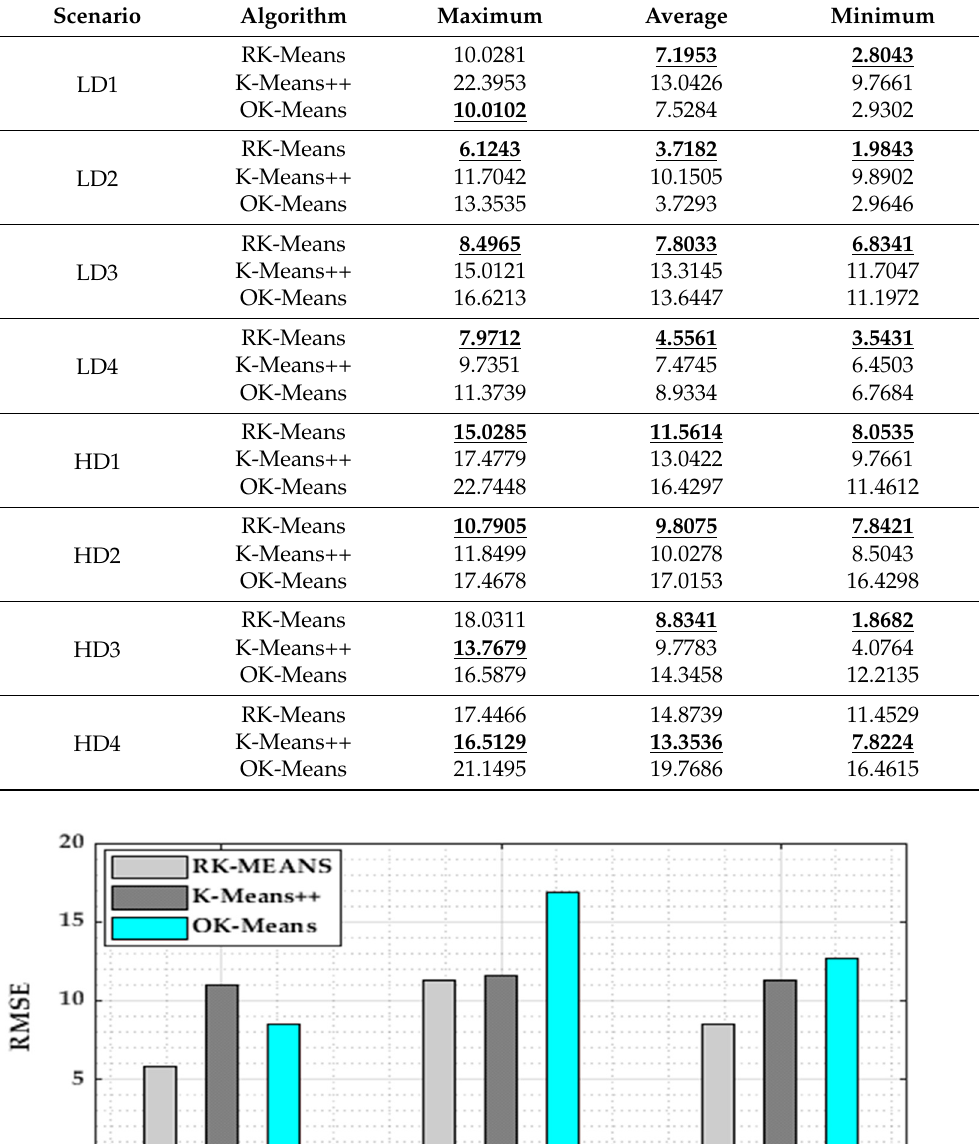
Table 7. RMSE numerical results.